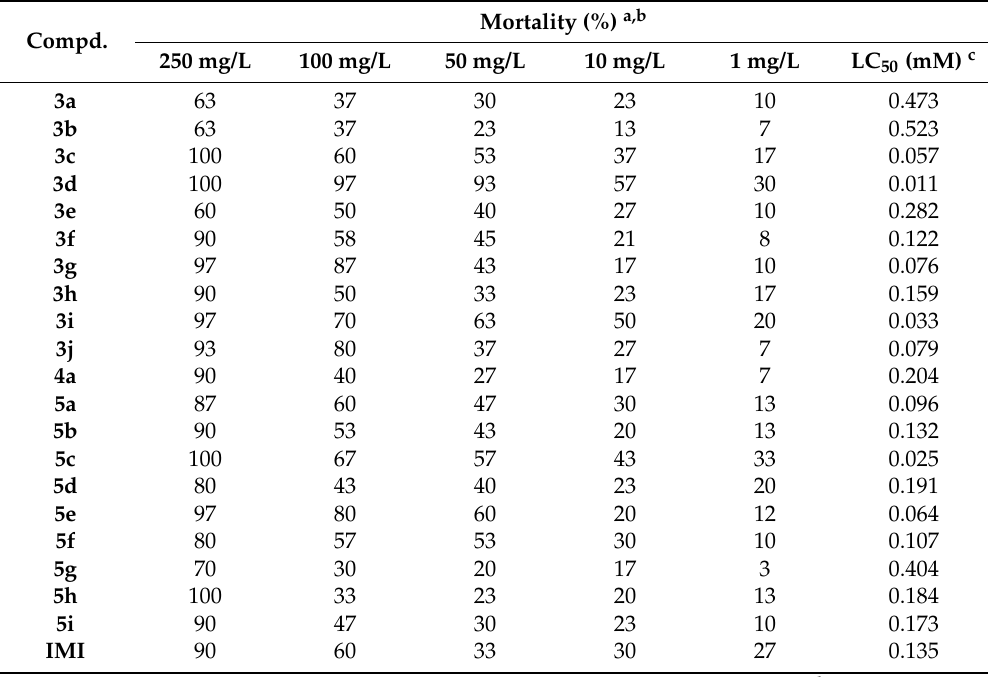
Table 1 varied drastically, depending upon the types and patterns of substitution on the phenyl ring and